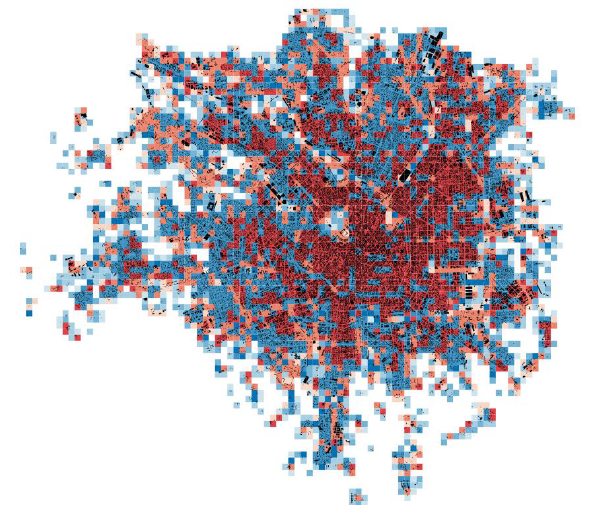
Figure 10 . Milan feature based 10